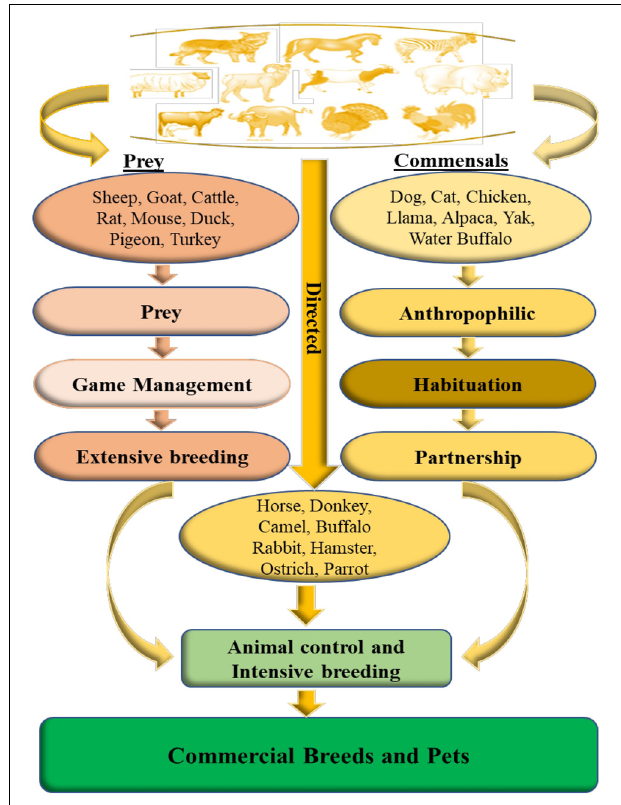
FIGURE 2 | Different pathways from wild to domestic animals (adapted from Larson and Burger,